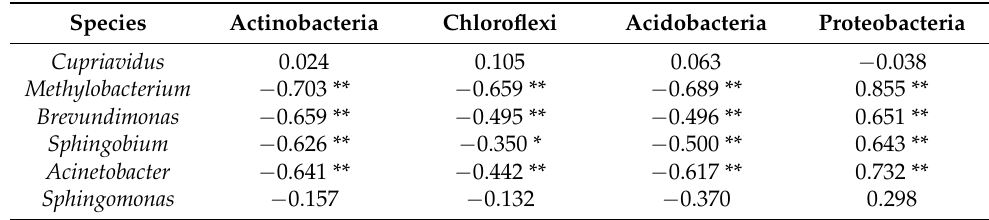
Figure 7. Complex interrelationships of soil bacteria with soil chemical properties, seedlings nutrient and biomass accumulation under NPK fertilization by the partial least squares path mode. Black solid and dashed lines represent significant effects ( p < 0.05) and non-significant effects ( p > 0.05), respectively. The data represent the magnitude and direction of the association between the two systems. Table 4. The correlation analysis of dominant phylum bacteria and dominant genera bacteria.